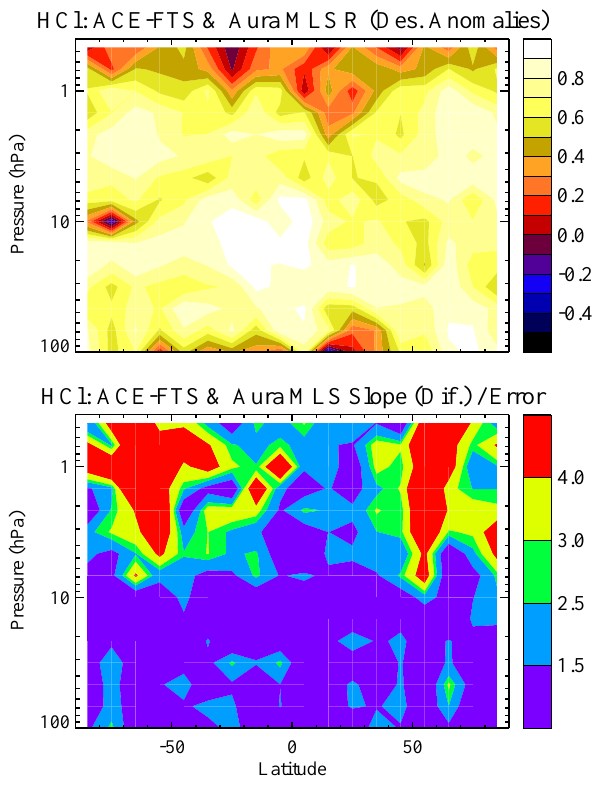
Figure 4. Latitude–pressure contours of time series diagnostics ob- tained from analyses illustrated in Fig. 3 for HCl from Aura MLS and ACE-FTS. Top panel: correlation coefficient for the deseason- alized time series. Bottom panel: ratio of the slope of the difference between deseasonalized series over the error in this slope. GOZCARDS HCl at 46 hPa for 35 o S